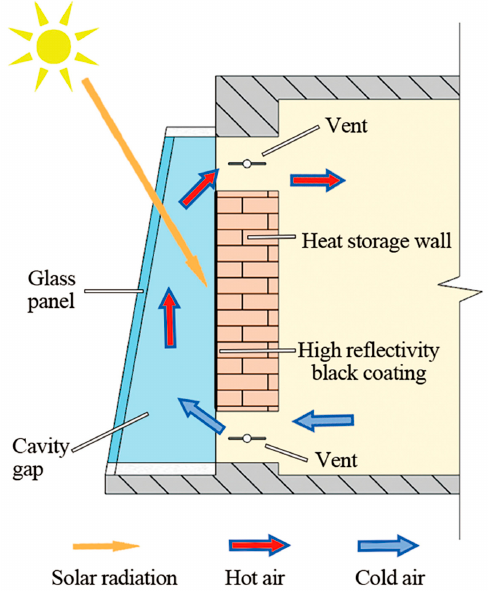
Figure 1. Diagram of the working principle of a T-wall.